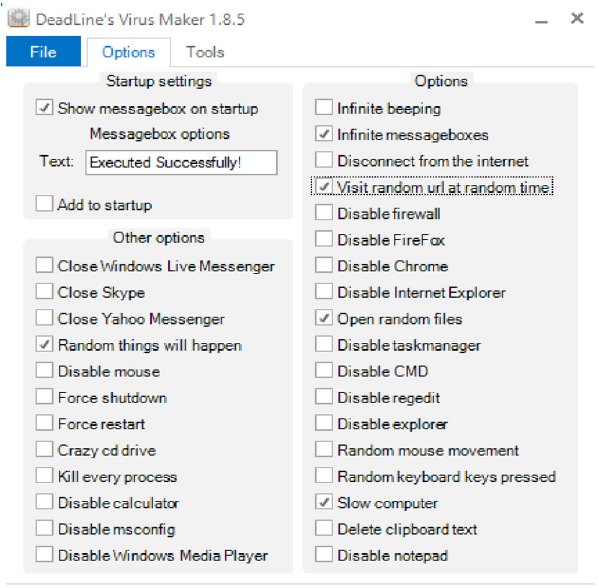
Table 1. Application execution schedule.